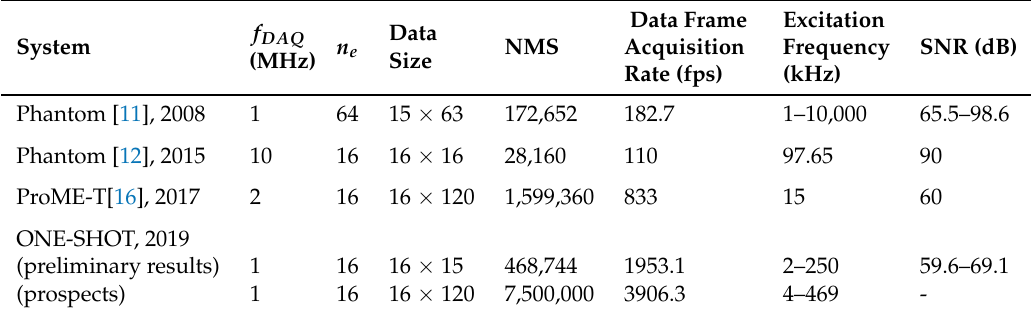
Table 1. Comparison of the performances of the ONE-SHOT simultaneous excitation difference with several high-rate EIT systems with single-frequency multiplexing strategies. Data f DAQ Data (MHz) Size